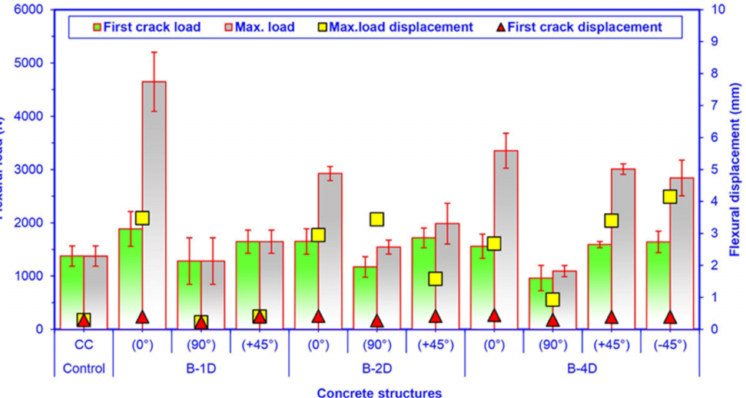
Figure 10. Average maximum off-axis flexure load-displacements and first crack load for all multiaxis 3D basalt fiber concretes.